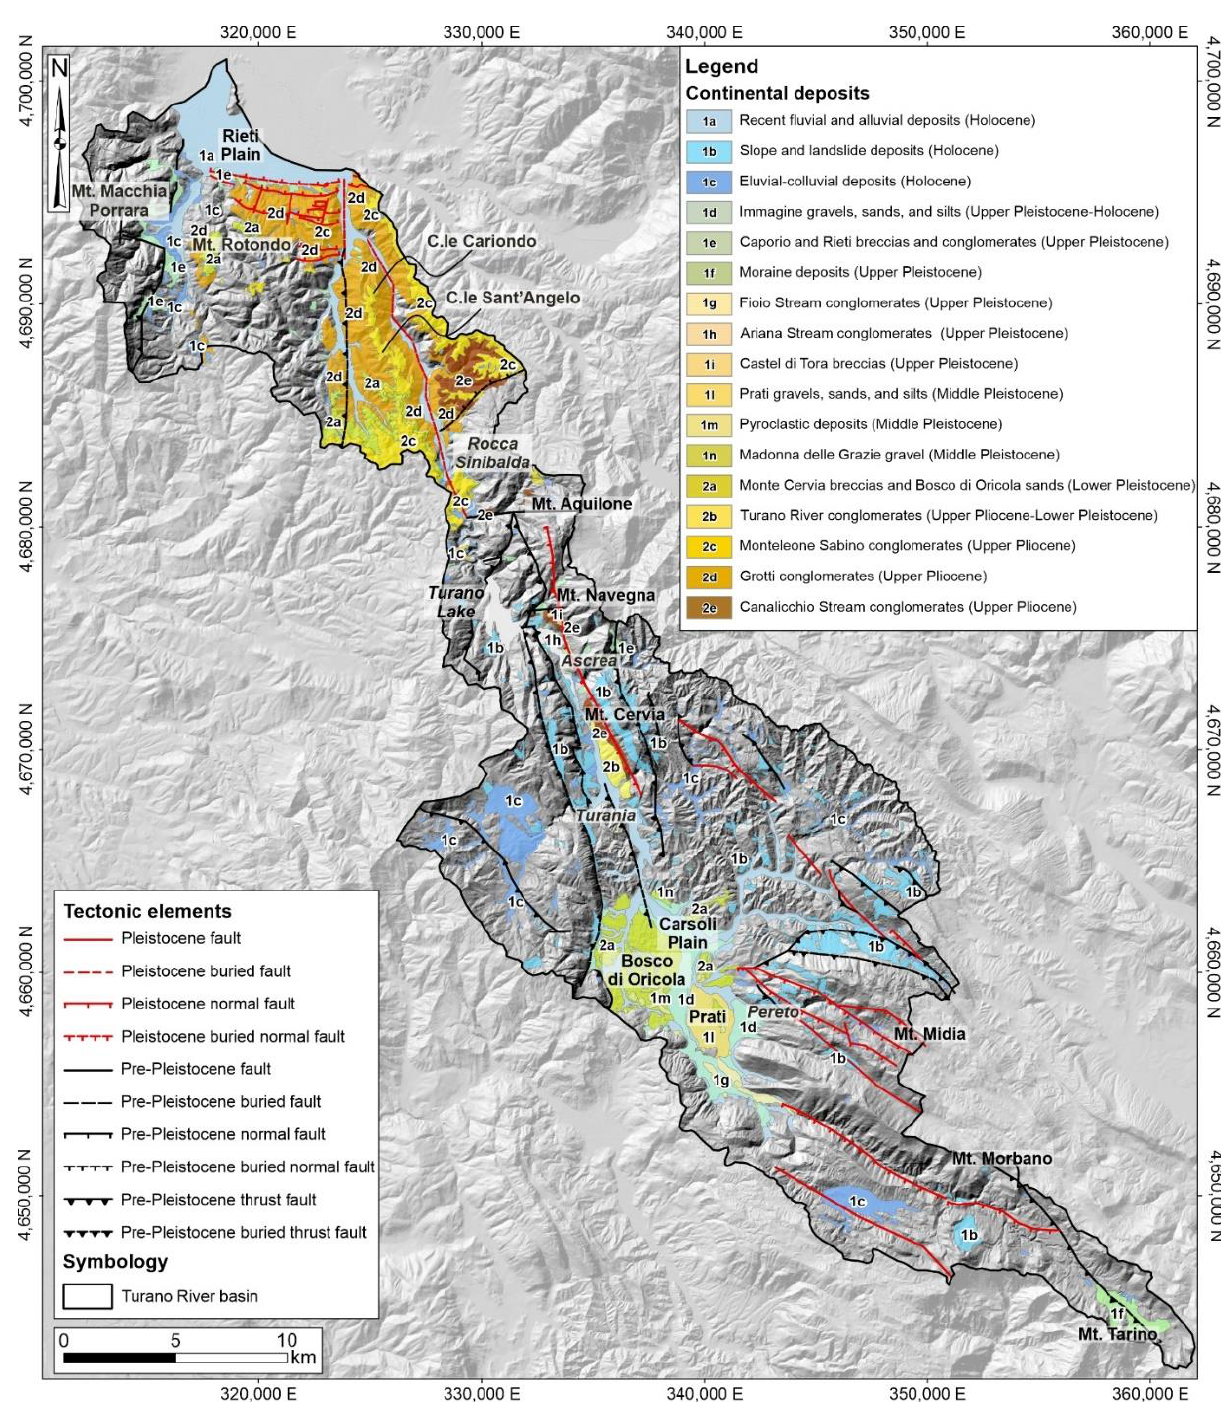
Figure 4. Plio-Pleistocene geological map of the Turano River basin. Note: numbers from 1a to 1n refer to lithological unit 1 in Figure 2a; numbers from 2a to 2e refer to lithological unit 2 in Figure 2a.